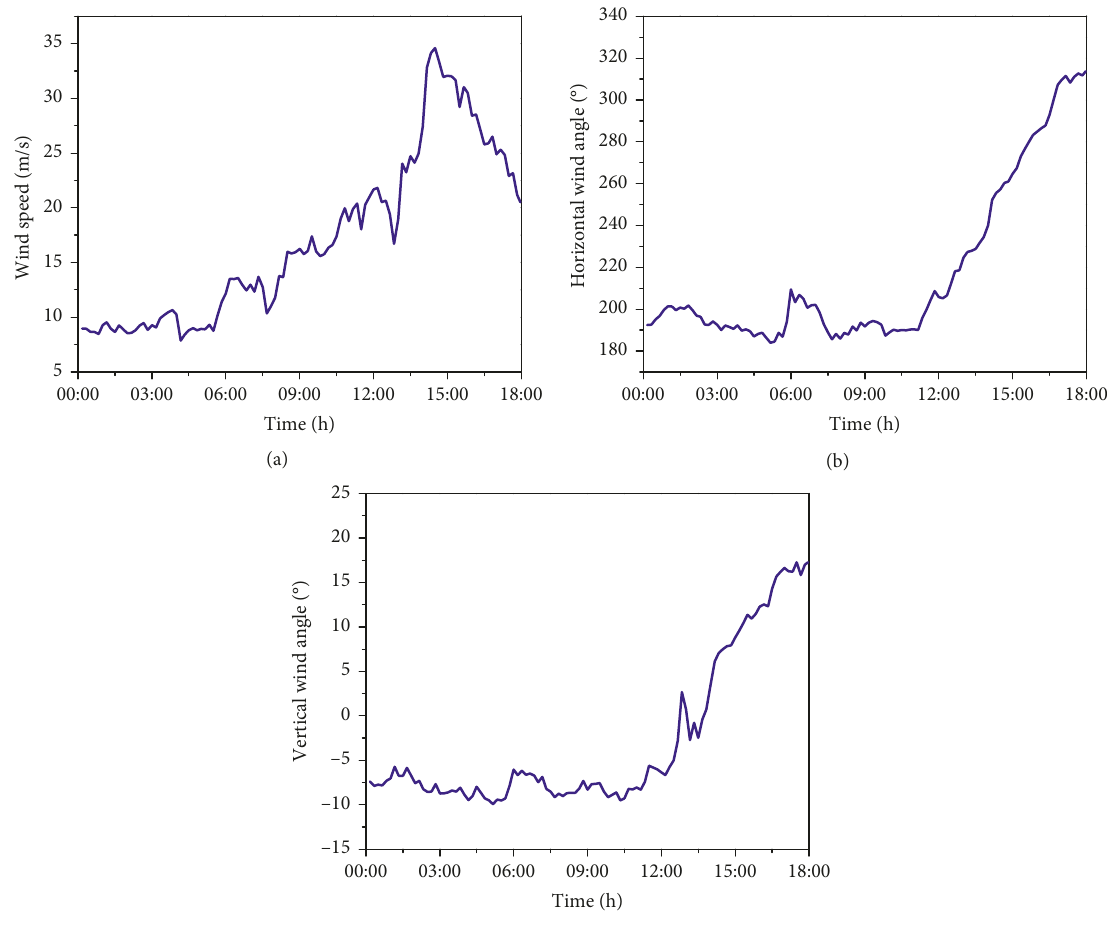
Figure 11: (a) Mean speed. (b) Horizontal wind direction. (c) Vertical wind direction.